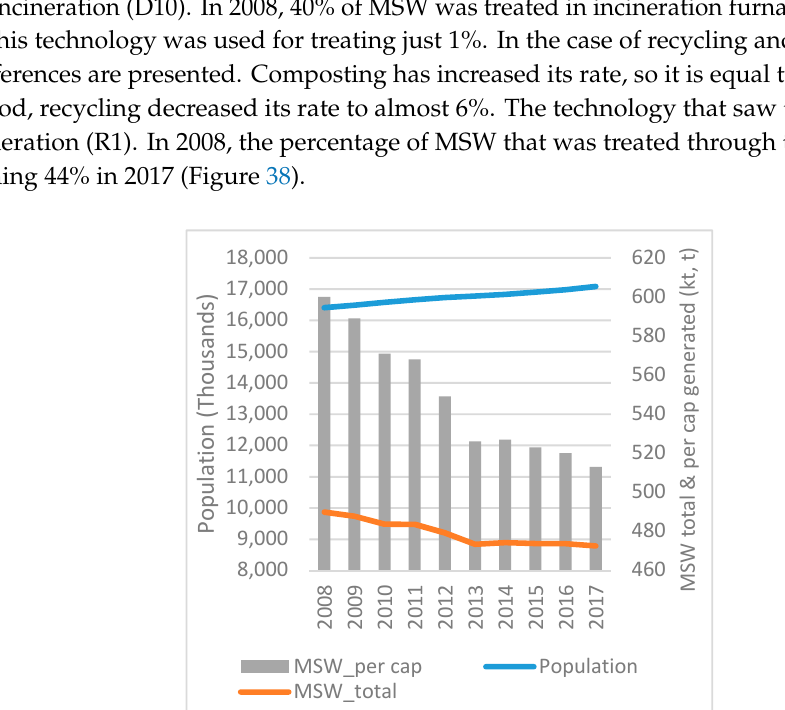
Figure 36. Waste treatment methods and PPP in Malta 2008–2017 (EUROSTAT 2019b, 2019c).